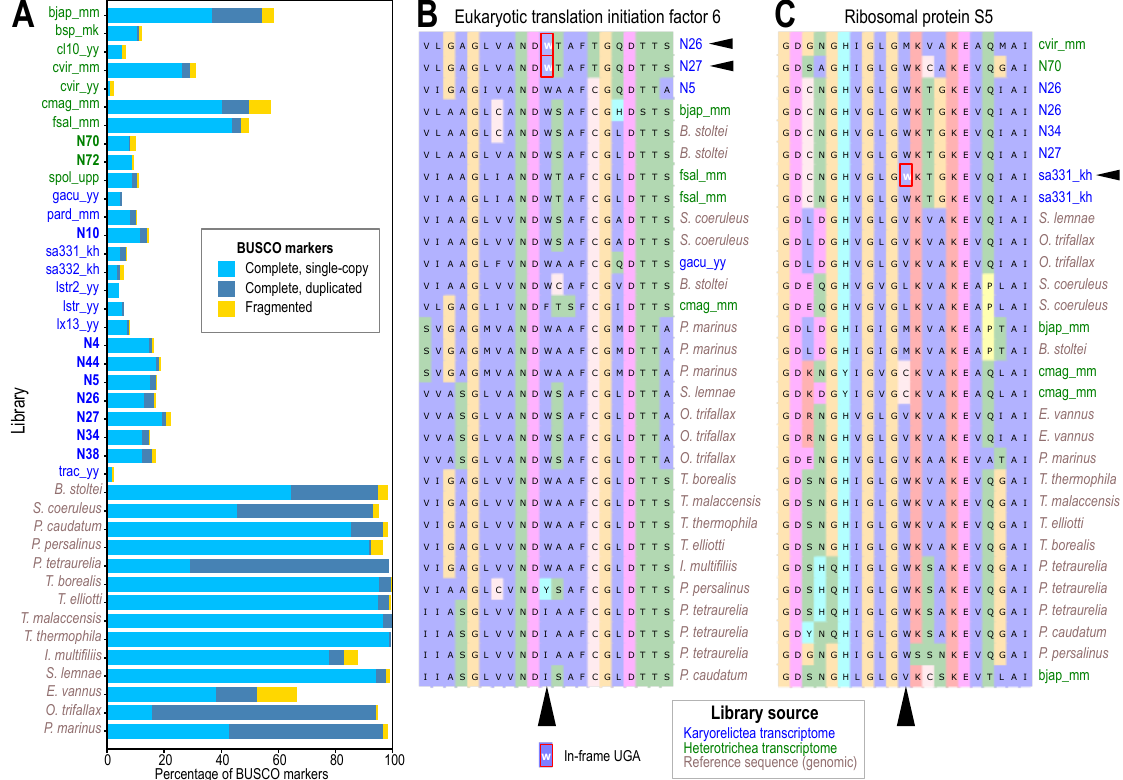
Figure 2 . In-frame coding UGAs in conserved marker genes. ( A ) Completeness estimates of heterotrich and karyorelict transcriptomes (library names in green and blue respectively), compared with genomic reference sequences from other ciliates (Table_S3.xlsx in [22]); BUSCO Alveolata marker set. ( B , C ) Two examples of alignments (excerpts) for conserved orthologous protein-coding genes (orthologs 20320at33630 and 23778at33630), which contain in-frame UGAs translated as W in karyorelict sequences, flanked by conserved alignment